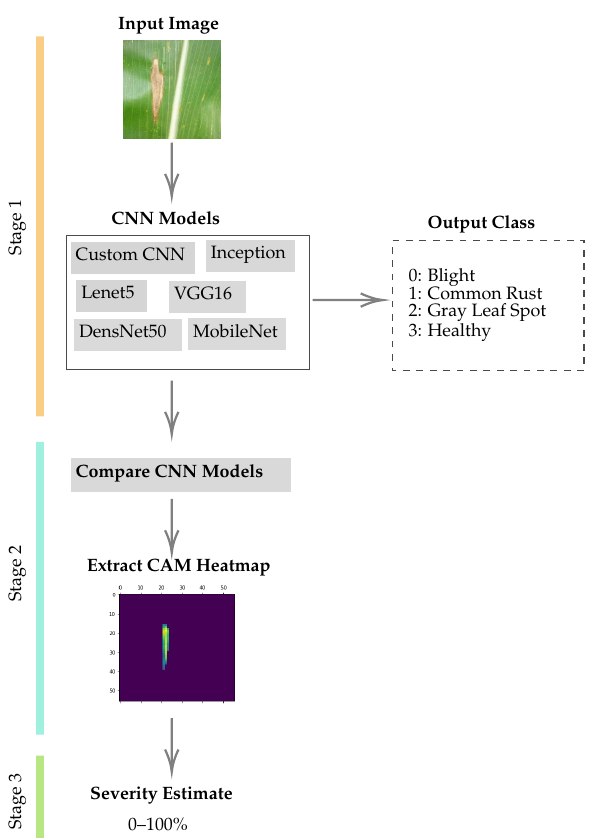
Figure 5. Research method of maize leaf disease classification and severity estimation using deep CNN features. As shown in this diagram, simultaneous maize leaf disease classification and quan- tification is the major component of our work, which comprise the following: CNN training, CAM heatmap extraction, and thresholding. First, several deep learning models are trained on the aug- mented PlantVillage maize leaf disease dataset. In Stage 2, the CAM extracted from the covnet layers from Stage 1 is obtained and eventually used for disease quantification. Although not illustrated in this diagram, the CAM can be treated as a 2D heatmap of pixels with different intensities. Bright pixels represent regions that have been identified by the CNN to be of great importance (regions of interest (ROI)), while darker regions correlate to a lack of features. In Stage 3, we use an adaptive thresholding technique that extracts the ROI from the heatmap of Stage 2 and represents that area as a percentage of the total leaf